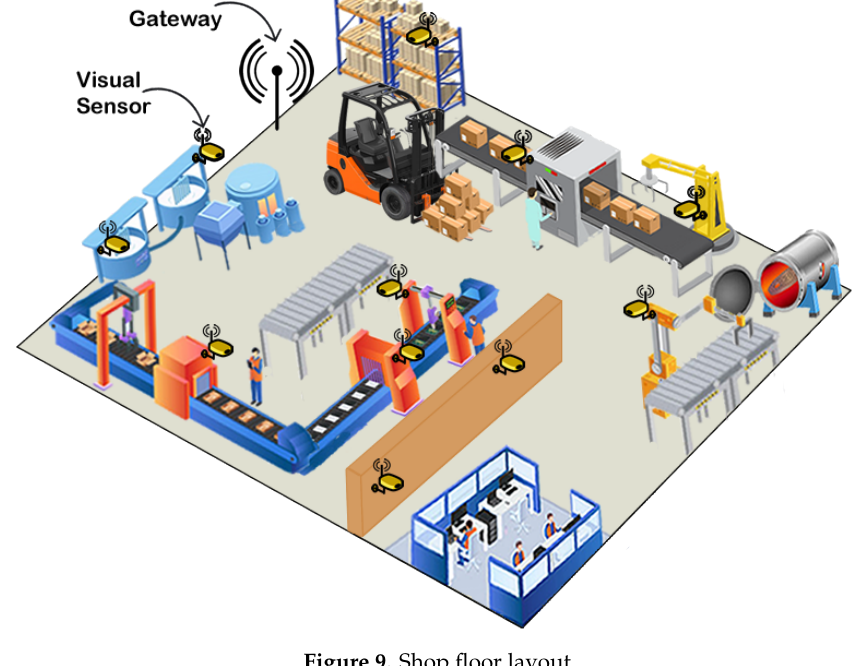
Figure 9. Shop floor